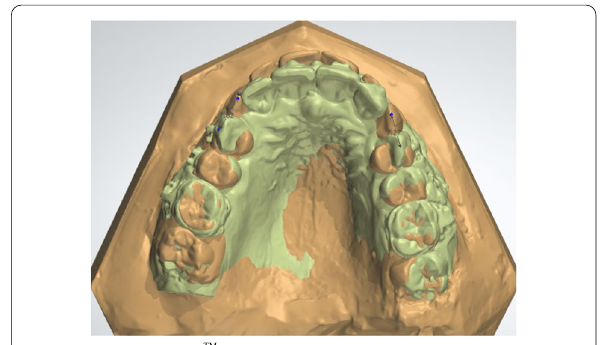
Fig. 2 Ortho Analyzer ™ software program superimposing the pre- and post-retraction dental casts